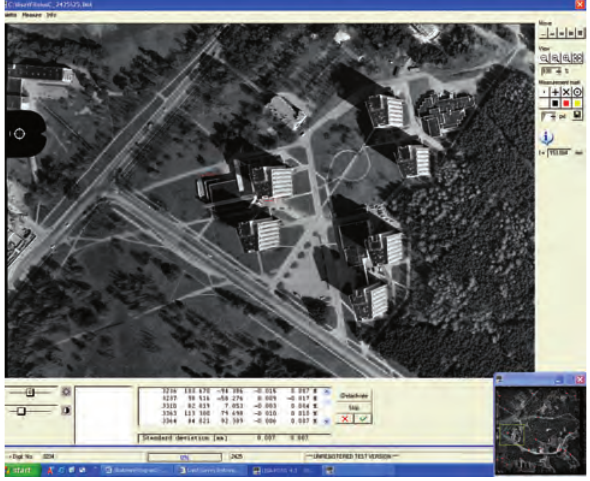
Fig. 4. Fragment from images inner orientation